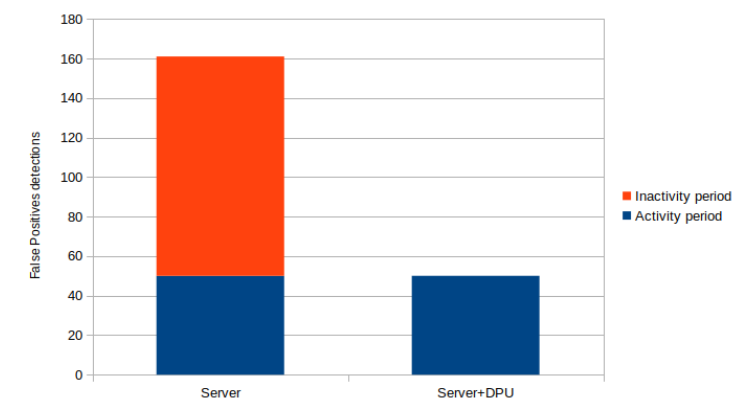
Figure 8. False positive detections during activity and inactivity